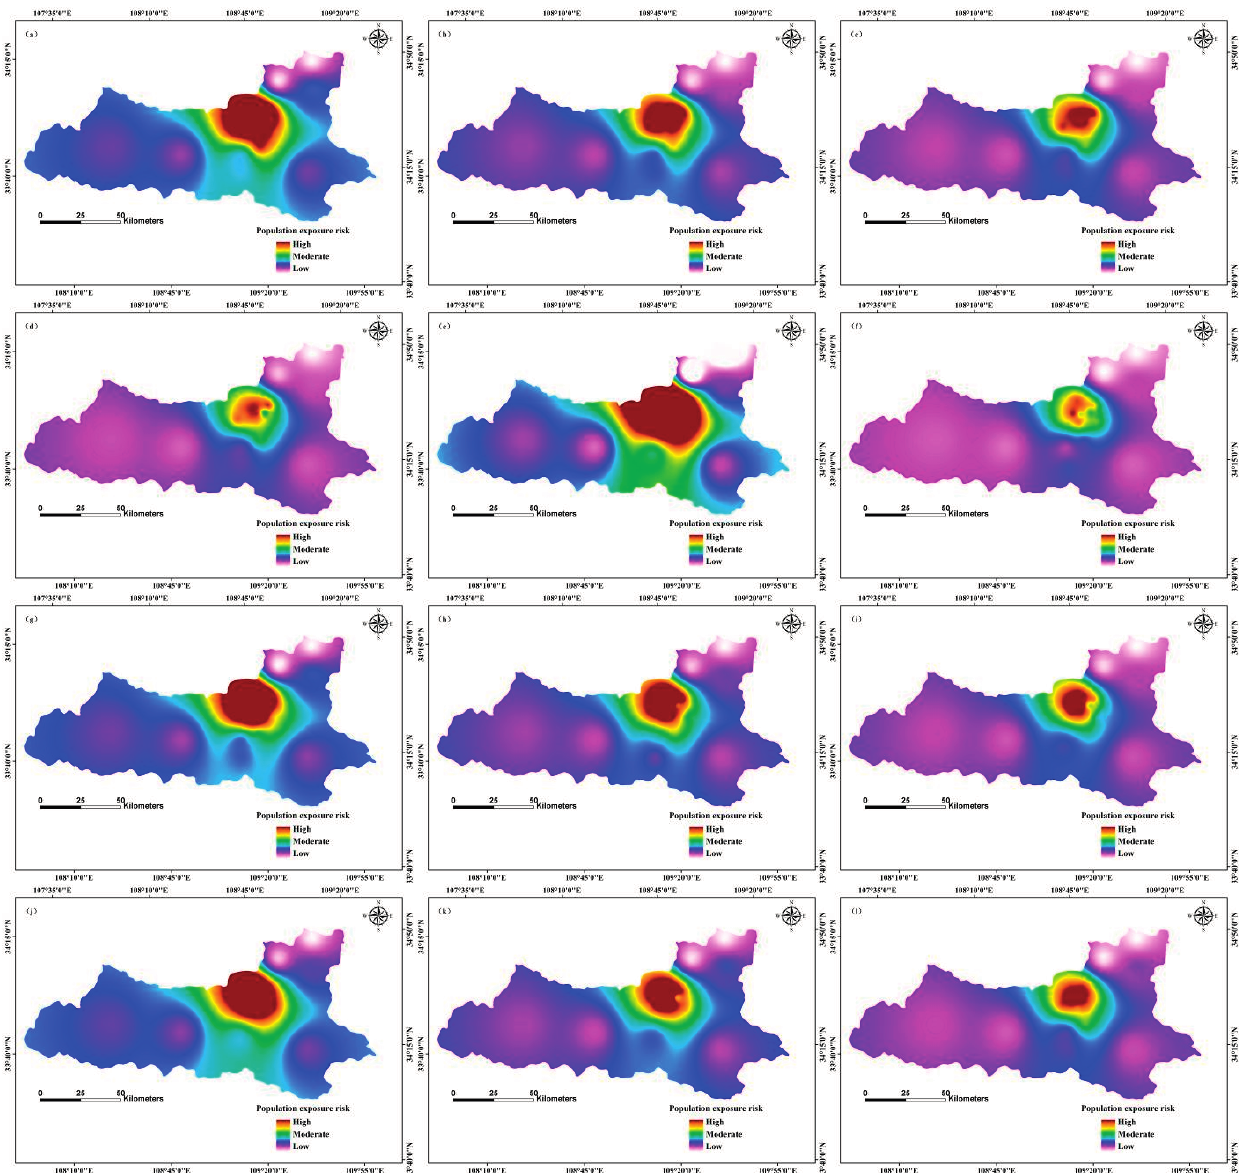
Figure 8. Risk of population exposure to PM2.5 in 2025 in Xi’an, China by month: ( a ) January; ( b ) February; ( c ) March; ( d ) April; ( e ) May; ( f ) June; ( g ) July; ( h ) August; ( i ) September; ( j ) October; ( k ) November; ( l )